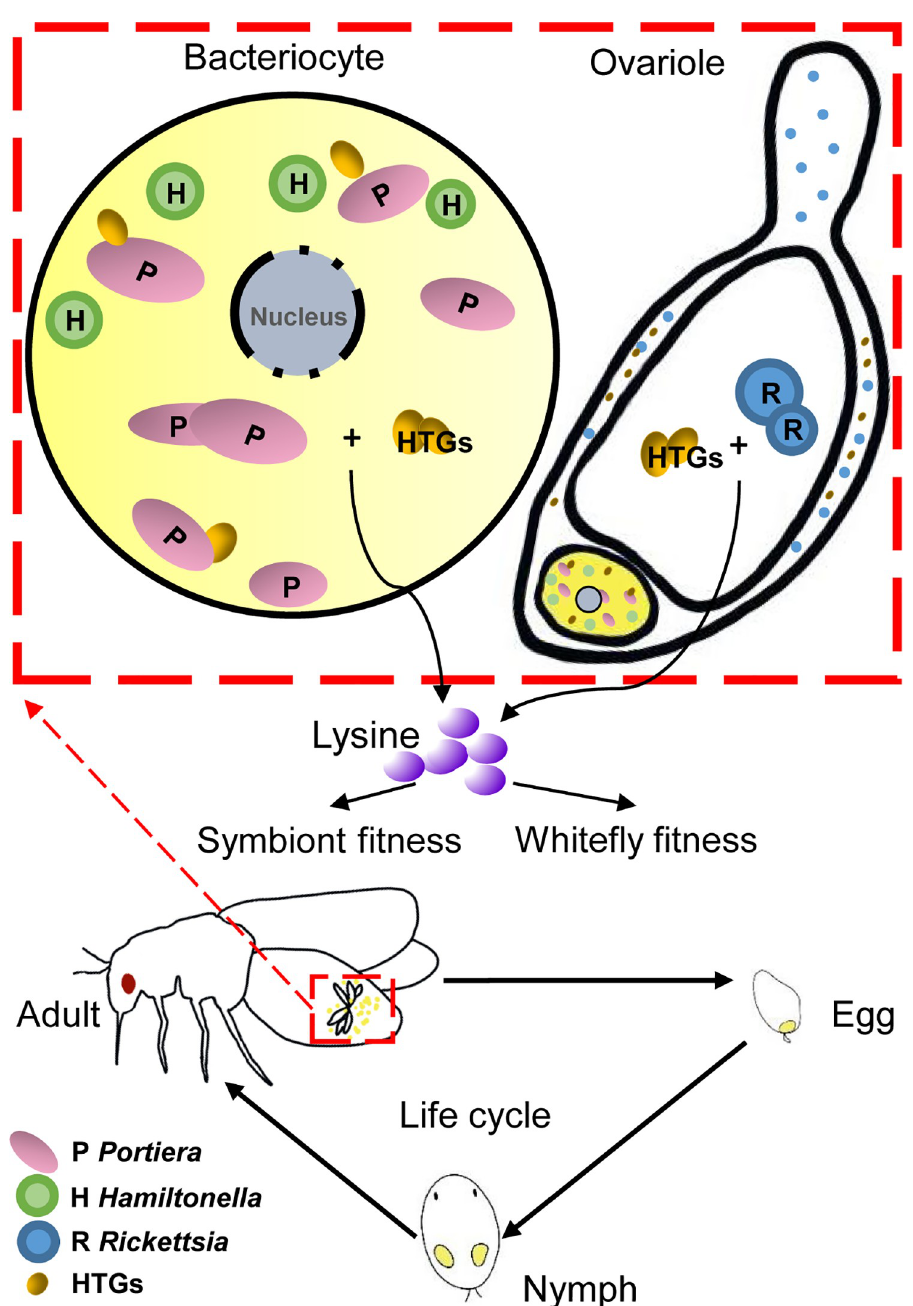
Fig 7. Schematic overview of how lysine provisioning by horizontally acquired bacteria genes promotes mutual dependence between whitefly and two intracellular symbionts. The whitefly lifestages consist of egg, nymphs and adult. Whiteflies can synthesize lysine through the cooperation of horizontally transferred genes (HTGs) and two symbionts (one obligate symbiont Portiera and one facultative symbiont Rickettsia ). The lysine synthesized through HTGs impacts the fecundity of adult whiteflies and titers of two symbionts. All 13 cultures or colonies from ten B . tabaci cryptic species were shown to possess lysine HTGs. Phylogenetic analyses revealed that whitefly DapB clusters with Rickettsia , DapF clus- ters with Pantoea and bacterial symbionts of P . stali , and LysA clusters with Planctomycetes.